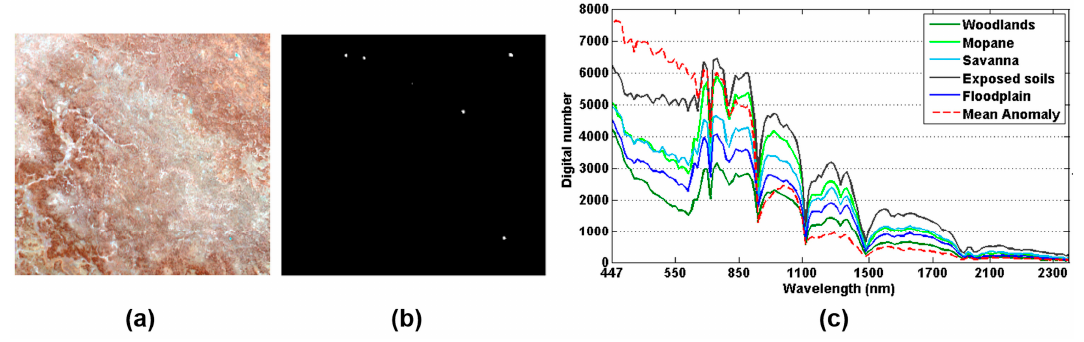
Figure 5. ( a ) The image scene of Botswana dataset by the EO-1 Hyperion sensor; ( b ) ground truth map of 35 pixels representing anomalies; and ( c ) spectral curves of background and average anomalous signature.